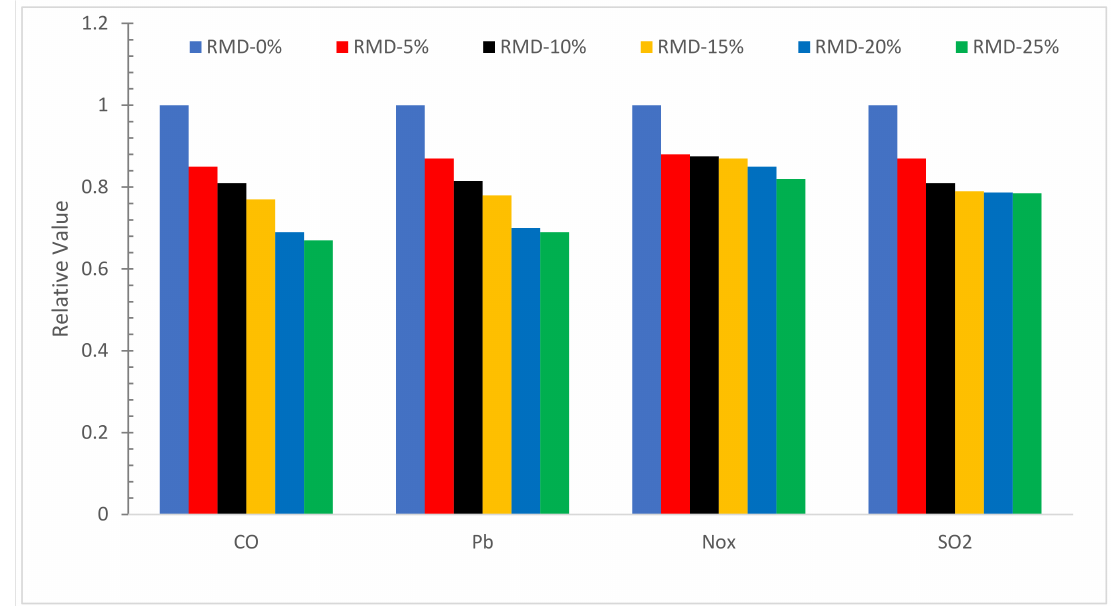
Figure 24. Air Pollution for Concrete with various percentages of RDM: Data Source